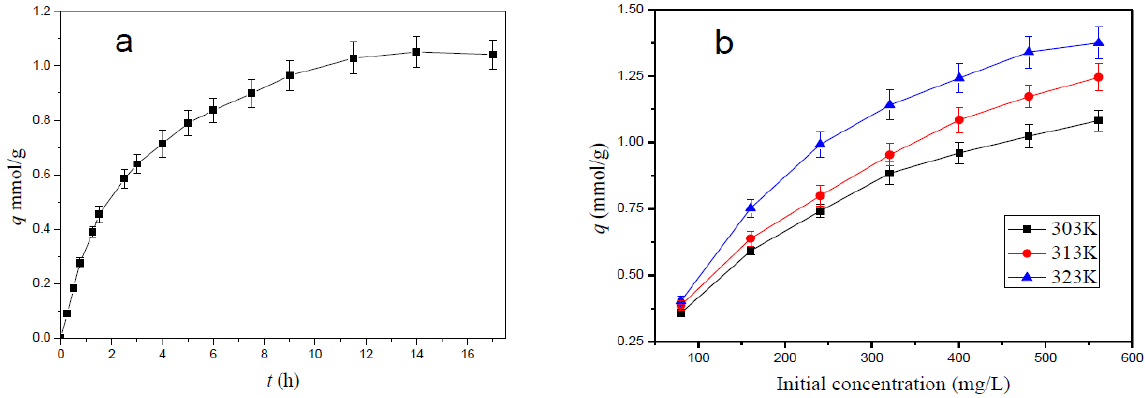
Figure 7. Effects of contact time ( a ) and initial concentration ( b ) on copper ion adsorption onto the hydrogel.